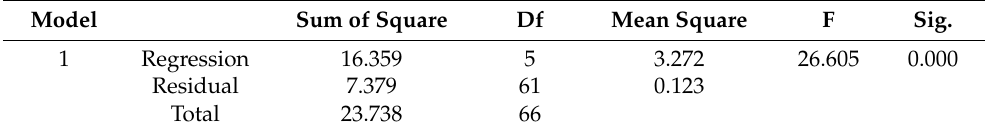
Table 6. ANOVA statistics of